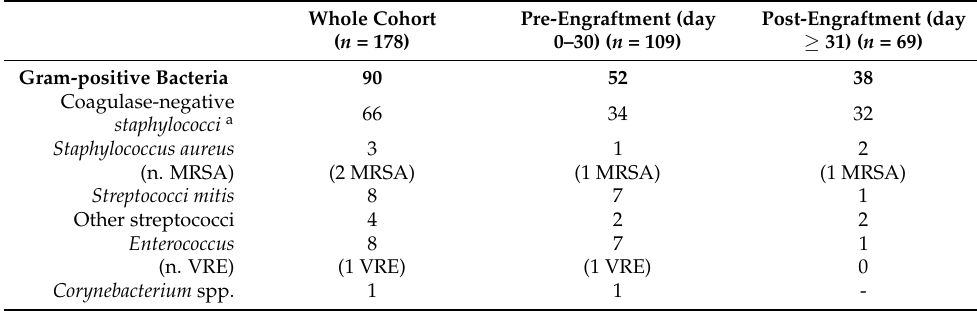
Table 2 details the etiology of BSIs according to the different time onsets from HSCT. Figure 2. Cumulative incidence rate of bacterial bloodstream infections (BSIs) at 1 year strati fi ed for: ( A ) donor type and ( B ) DRI. Death or relapse without BSIs is considered the competing event. Table 2. Microbiological etiology of BSIs